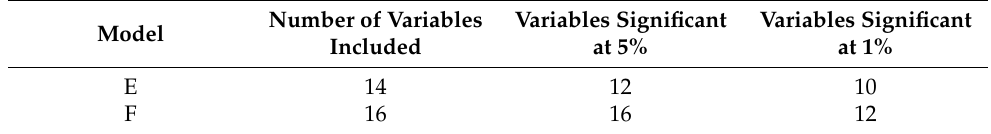
Table 5. Summary of models E and F to the number of significant variables according to 5% and 1% levels, respectively.